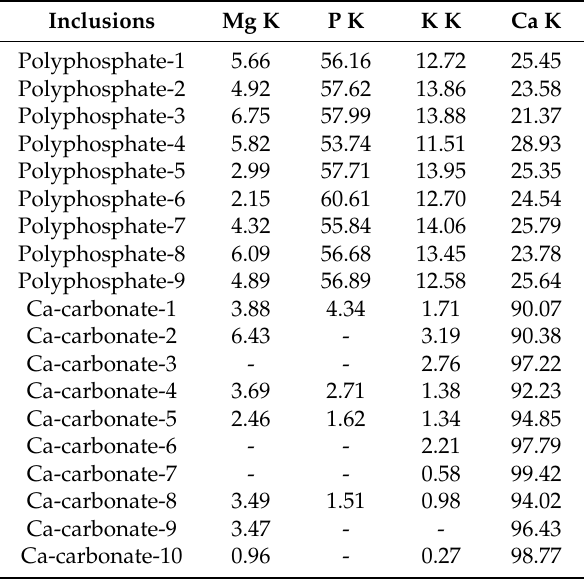
Table A3. Atomic ratios of Mg-P-K-Ca within polyphosphate and carbonate inclusions formed by Ca . S. calcipolaris G9 grown in BG-11 medium for two